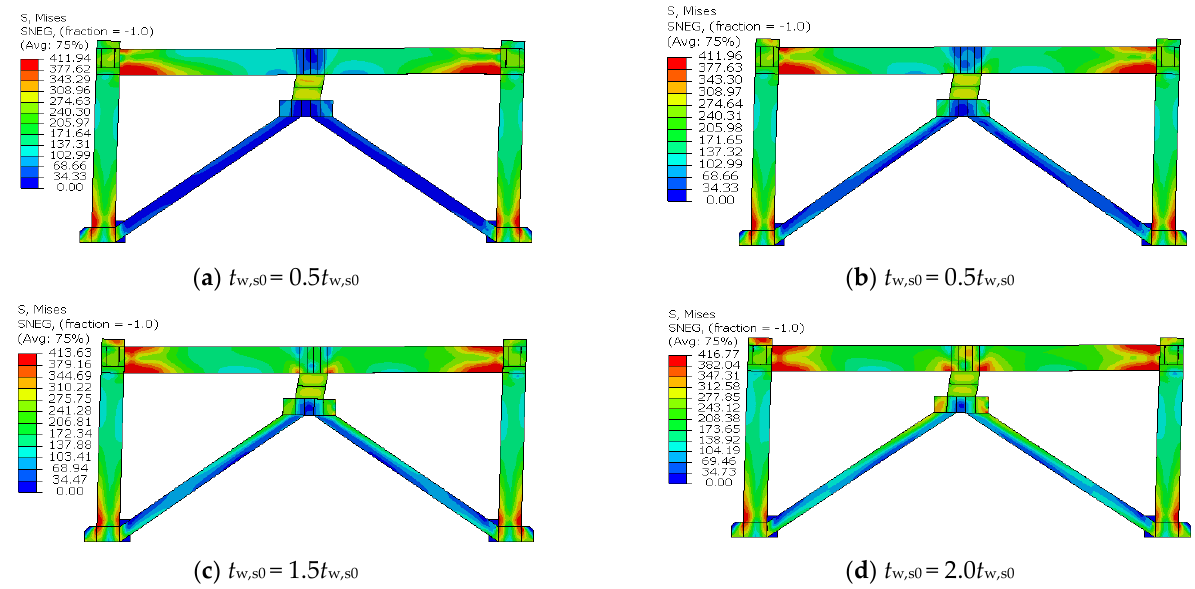
Figure 22. Stress nephograms of a steel frame for different t w,s values.